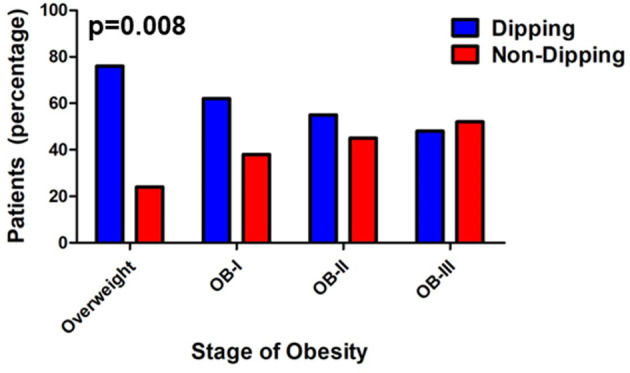
Prevalence of non-dipping increases with severity of obesity. Values are presented as percentage with Somer's D-test (p = 0.008, Somer's D-test).